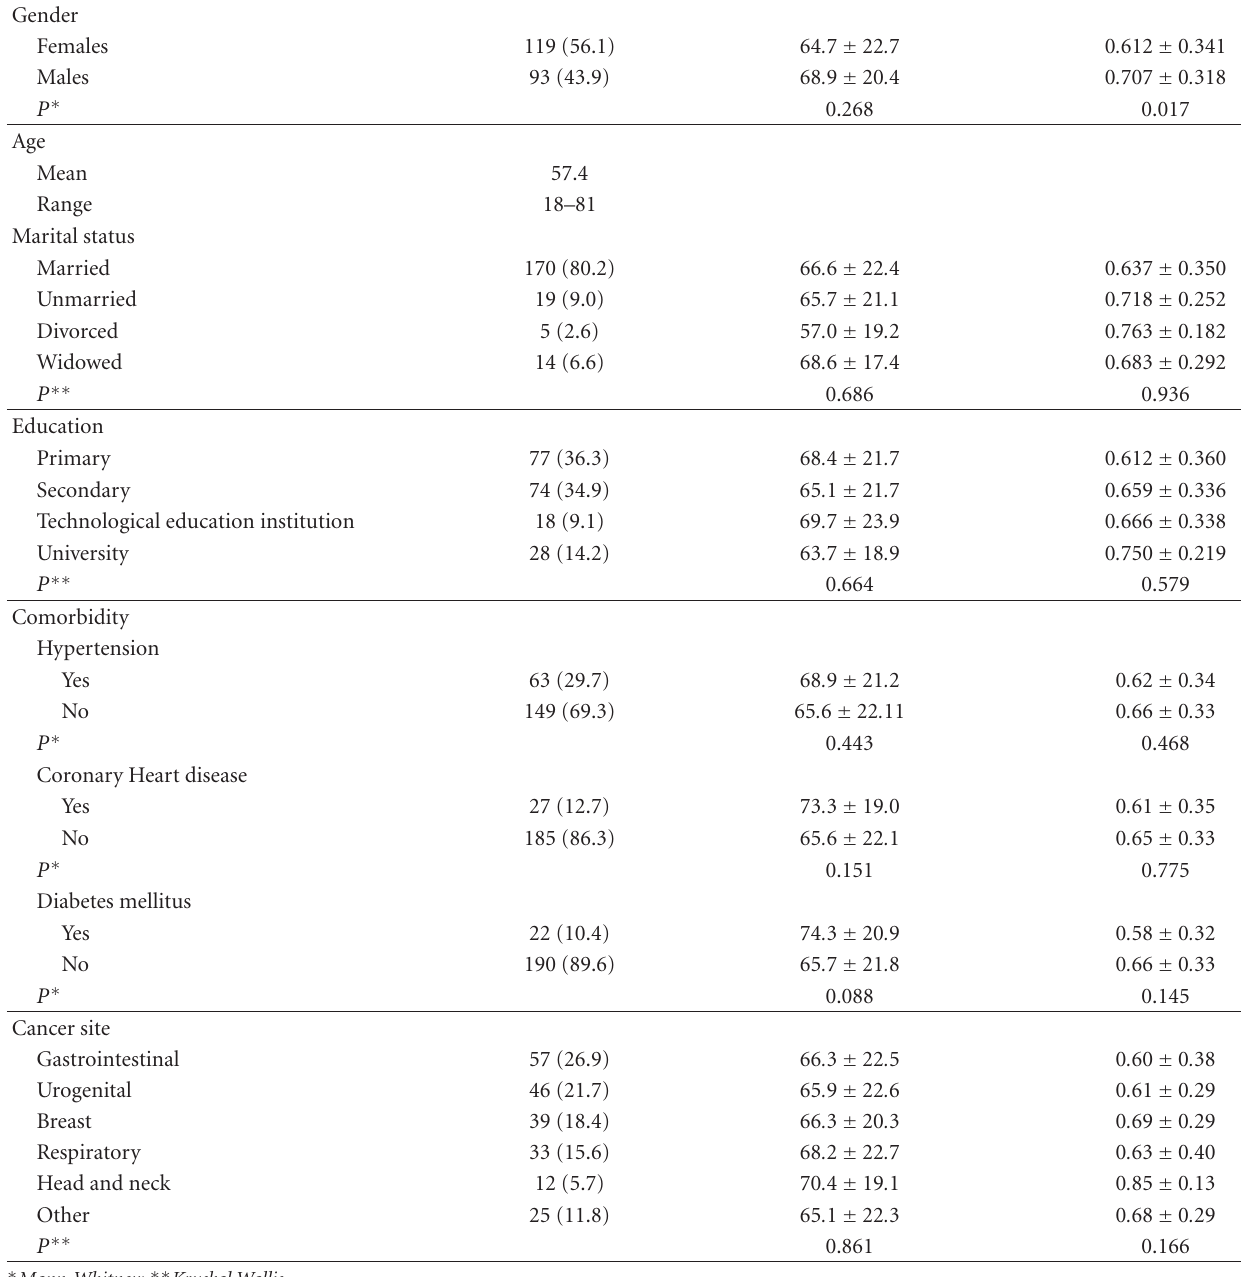
Table 1: Patients’ sociodemographic and clinical characteristics and EQ-5D VAS and Index